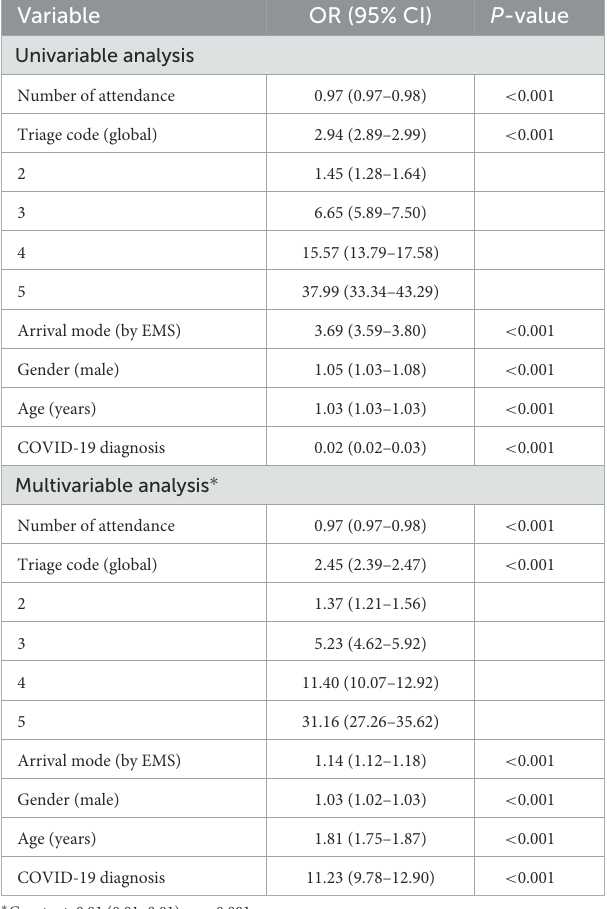
TABLE 3 Logistic regression analysis between the appropriateness of ED attendance and attendance-associated factors. Variable P